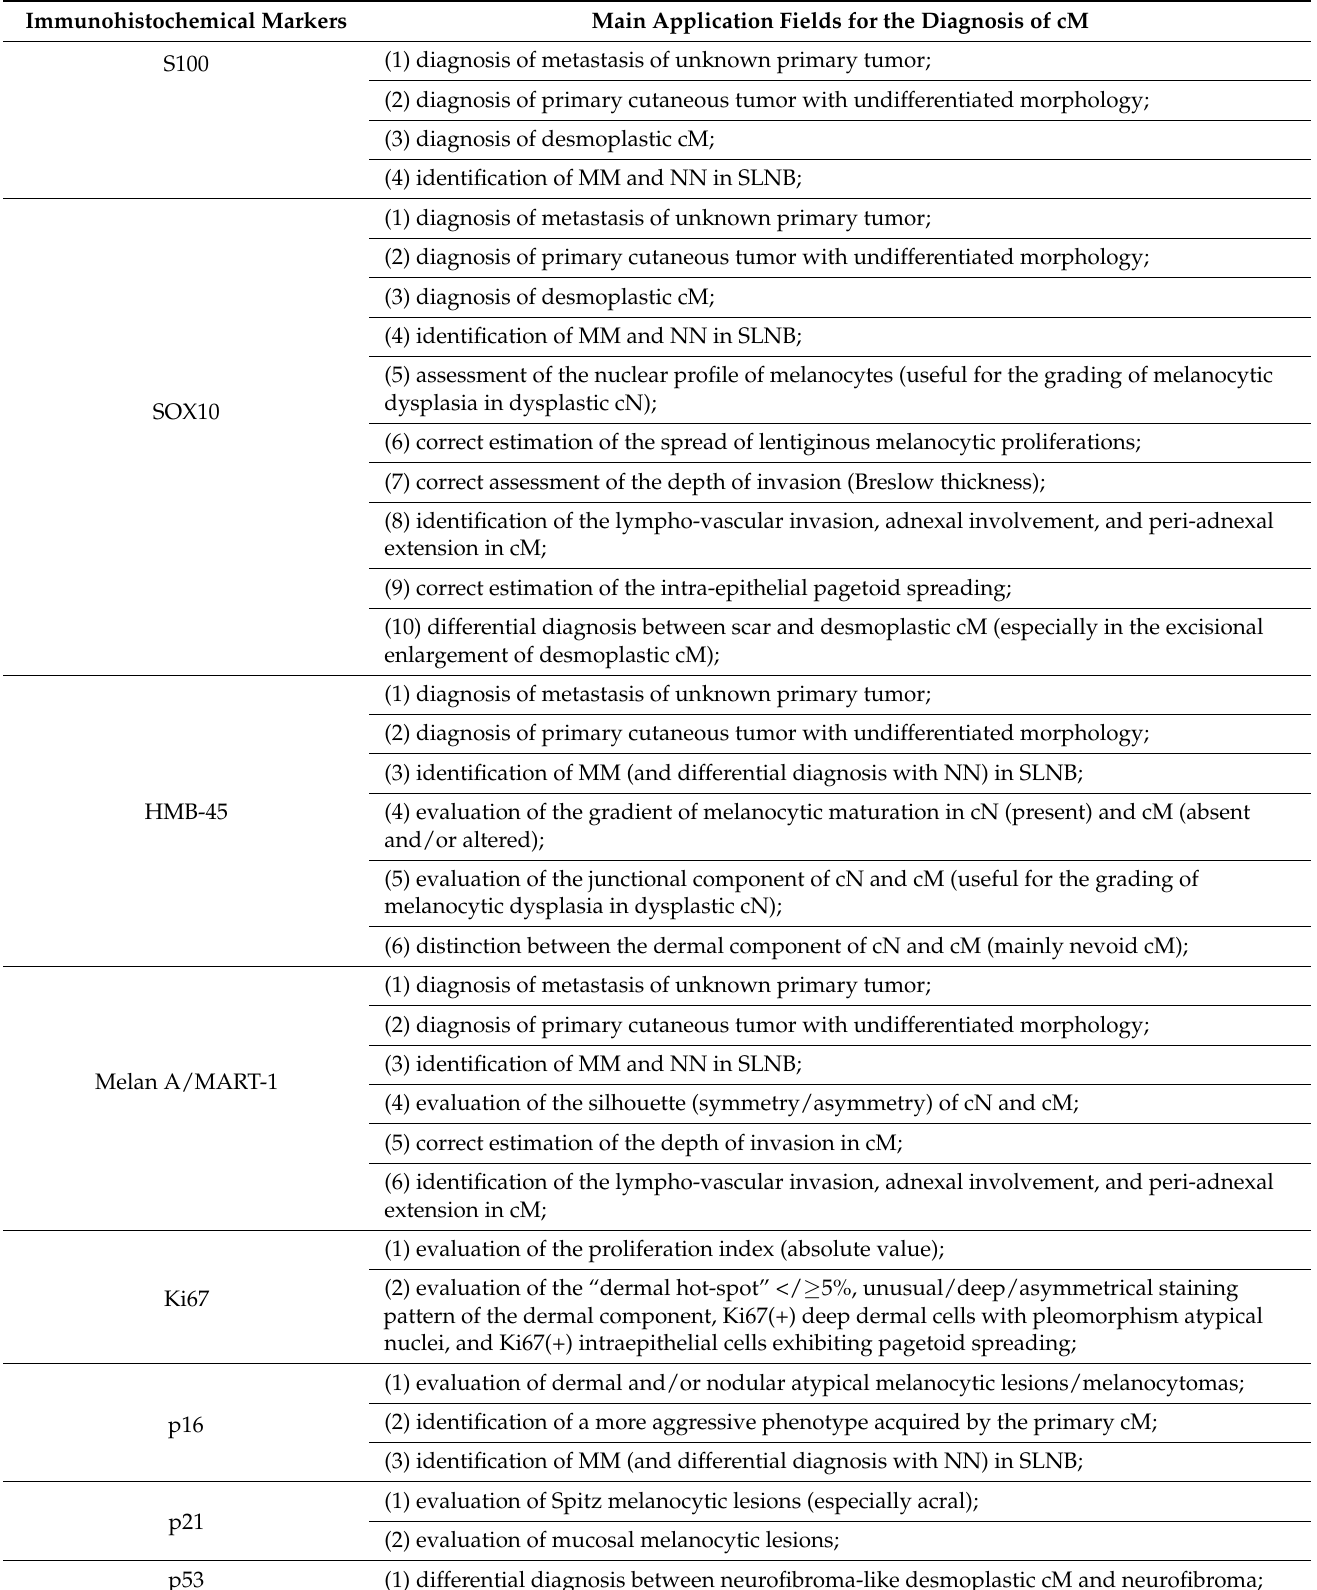
Table 1. Summary of the main application fields for the immunohistochemical markers that are most frequently adopted for the diagnosis of